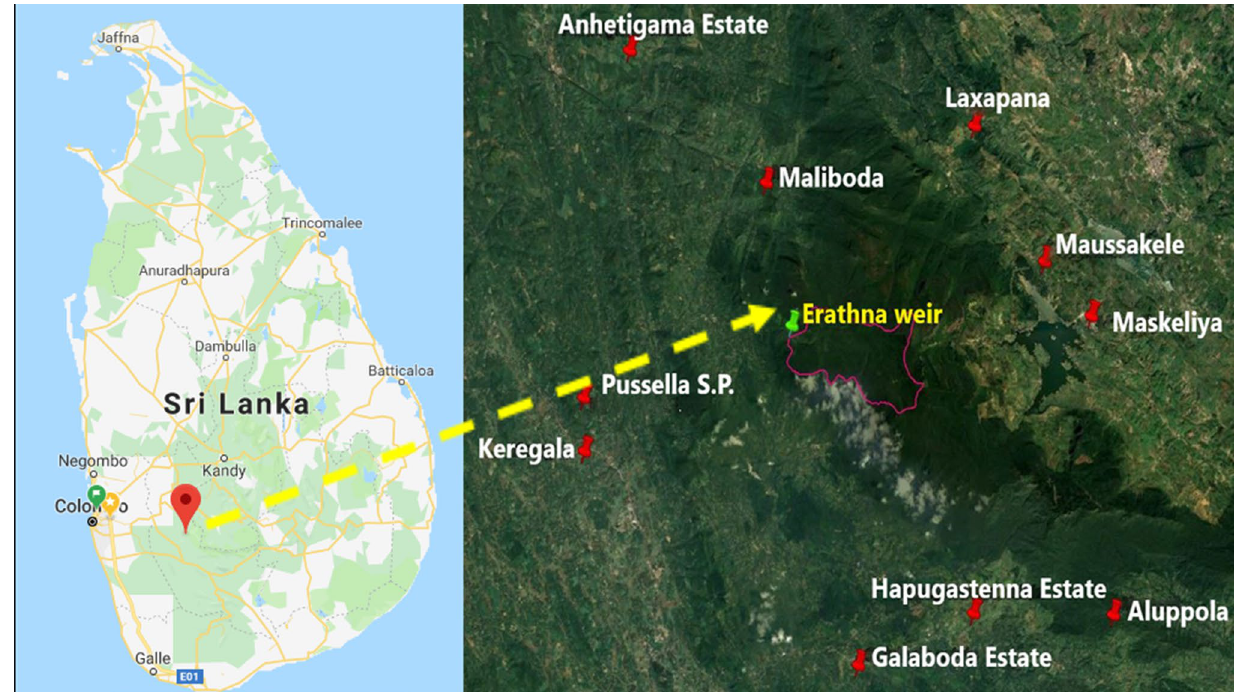
Fig. 1 Erathna catchment and its surrounding rain